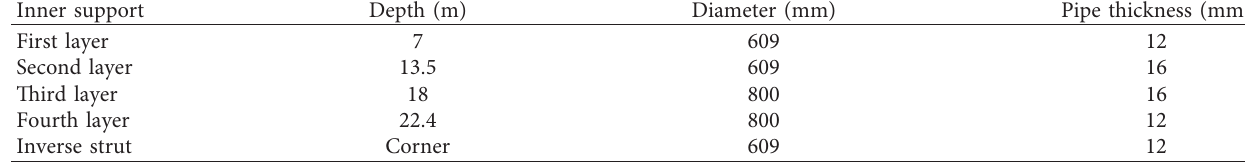
Figure 1: The profile of the supporting system and layer distribution. (a) The in situ construction profile. (b) The cross-section profile [13]. Table 1: Parameters of the supporting